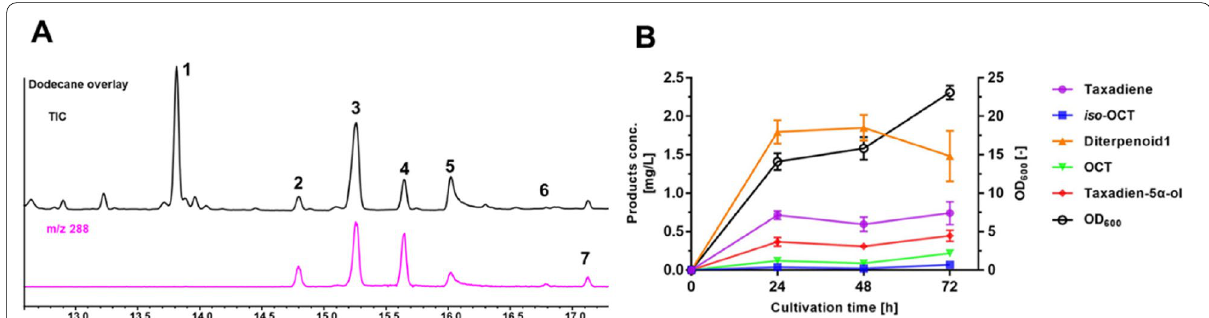
Fig. 1 De novo synthesis of oxygenated taxanes in E. coli cell factories. A GC–MS analysis of the products of TaolE1 strain. Seven compounds are taxa ‐ 4(5),11(12)‑diene ( 1 ), 5(13)‑oxa‑3(11)‑cyclotaxane ( iso ‑OCT, 2 ), diterpenoid1 ( 3 ), 5(12)‑oxa‑3(11)‑cyclotaxane (OCT, 4 ), taxadiene‑5α‑ol ( 5 ) and other unknown mono‑oxygenated diterpenoids ( 6, 7 ). B Products concentrations of taxadiene and oxygenated taxanes at 48